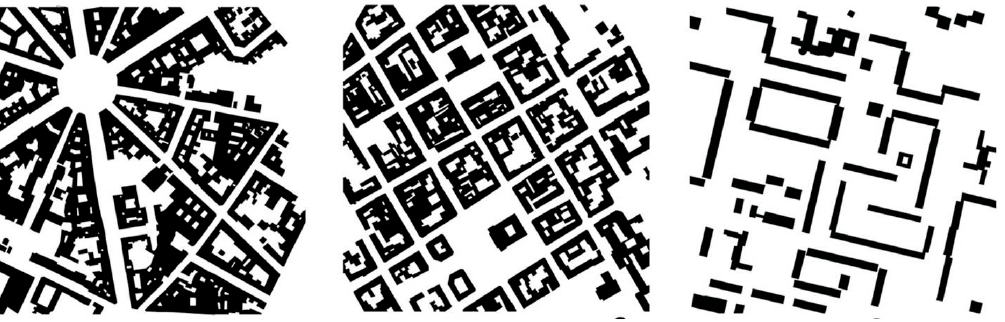
Figure 3. Urban fabric and historic intended use for waste quality assessment.